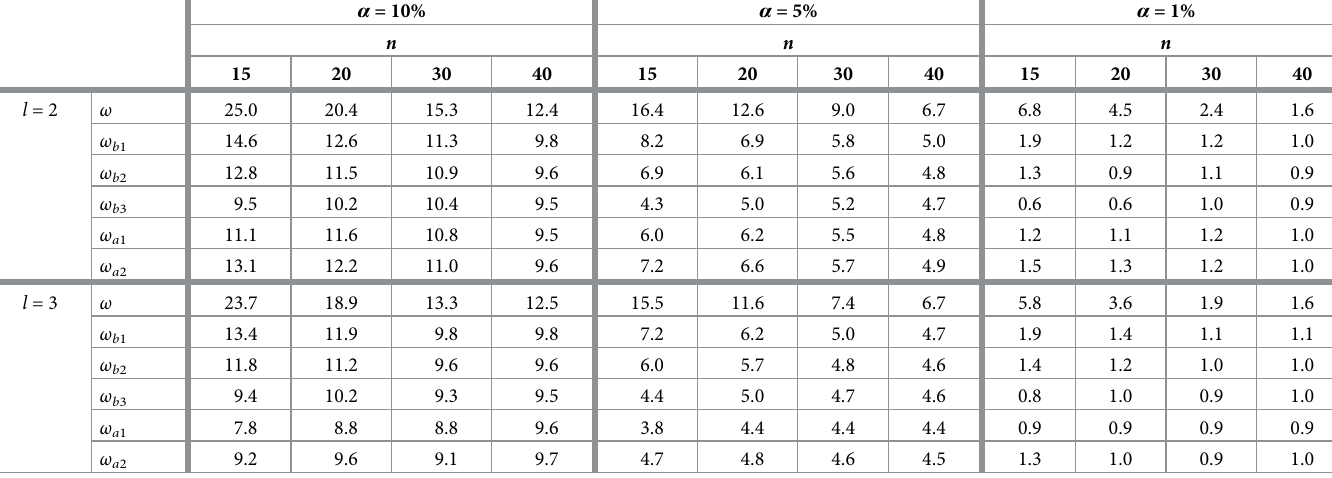
: b ; d ¼ 0 ( l = 2) and H 0 2 3